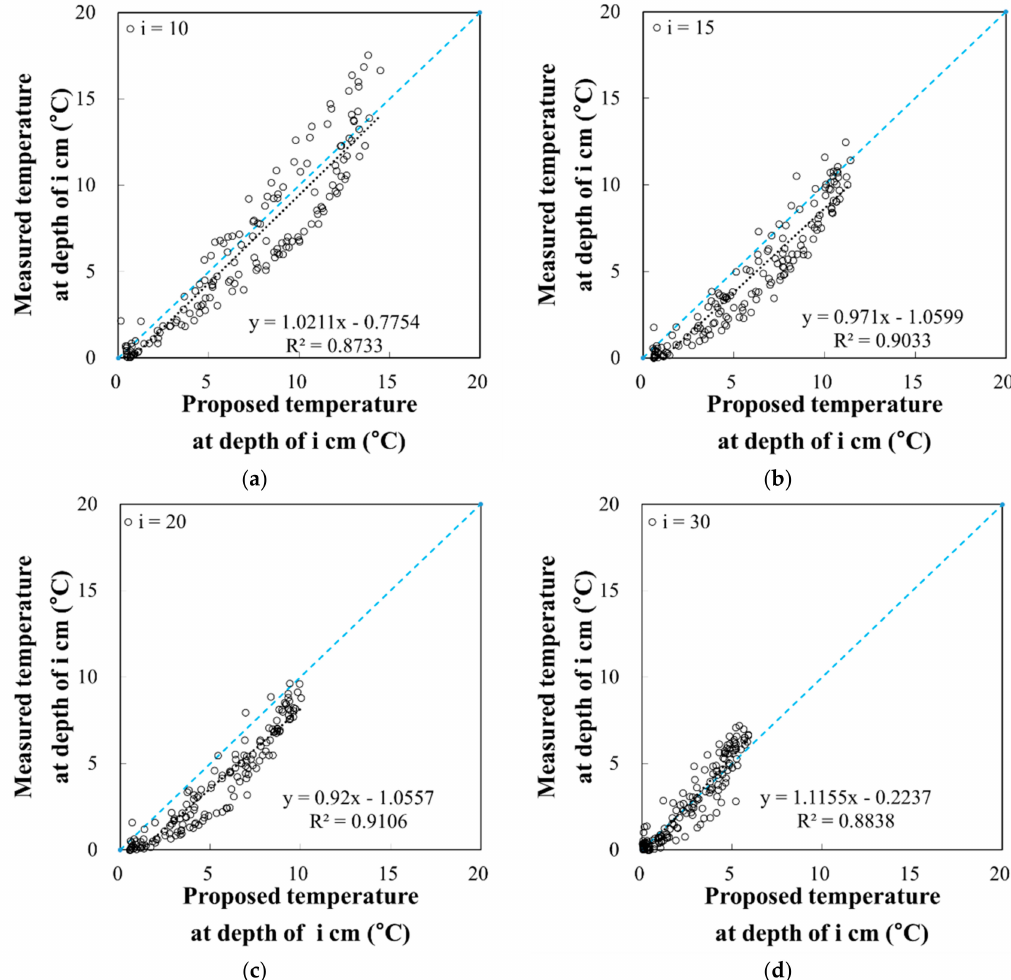
Figure 12. Regression analysis for measured and predicted temperature curves for additional data at depths of ( a ) 10 cm; ( b ) 15 cm; ( c ) 20 cm; and ( d ) 30